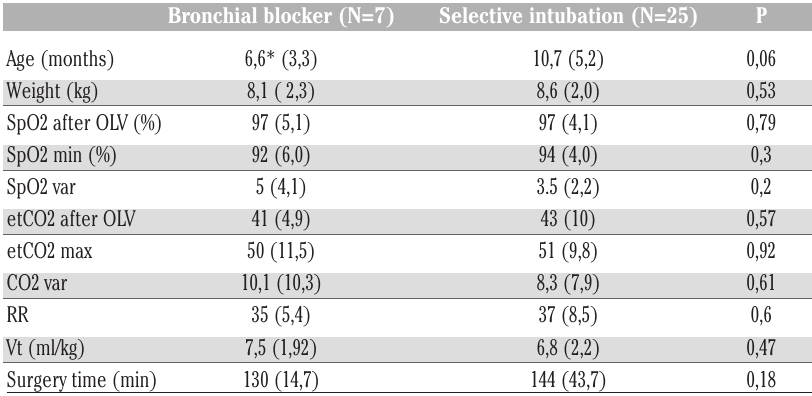
Table 2. Bronchial blocker and selective